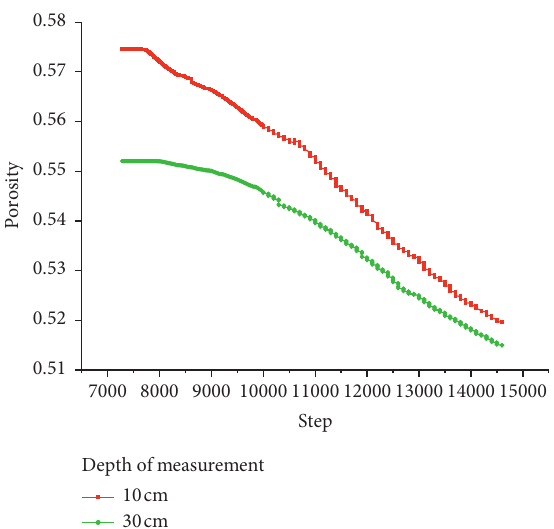
Figure 19: Curve of porosity change of 50 cm thick reclaimed soil with three